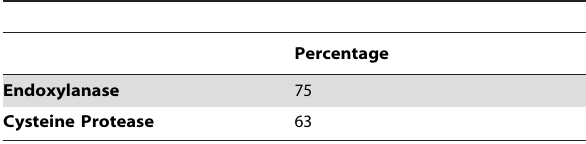
Table 2. Percentage of allergic individuals with IgE-reactivity to the BGP coat cysteine protease and endoxylanase.